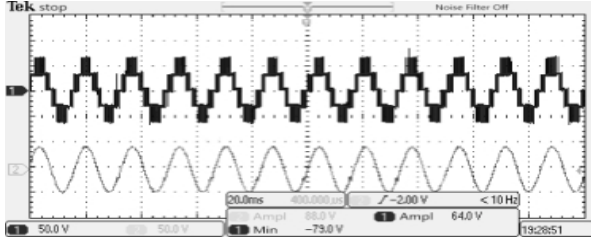
Figure 22. Output line voltage and current waveform.